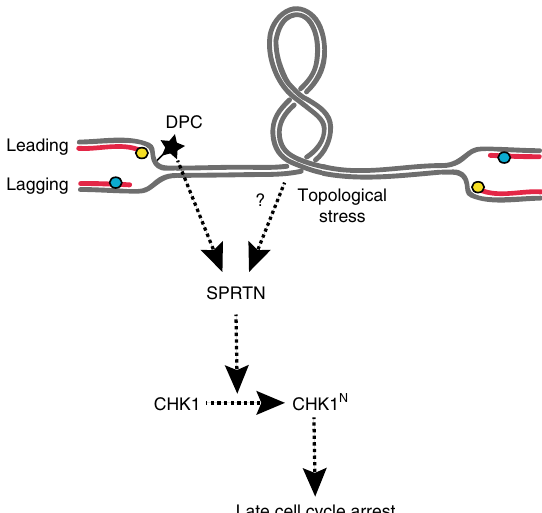
induce un-programmed termination sites where adjacent replicons the completion of replication. Under these circumstances the SPRTN-CHK1 axis inhibits cell cycle progression to avoid segregation of partially replicated